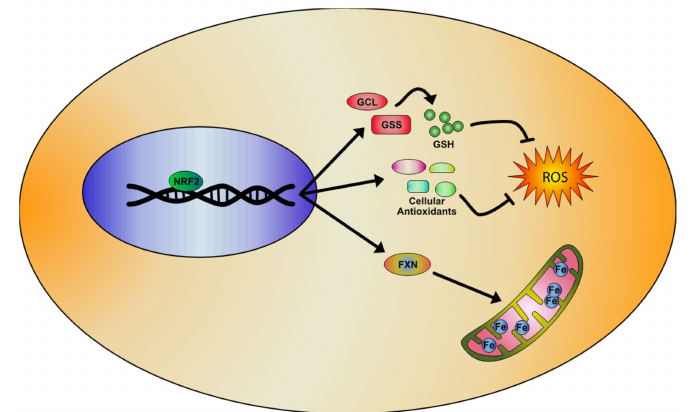
Figure 2. Representative model of the NRF2 signaling pathway activation in Friedreich’s Ataxia (FA), based on literature evidences. NRF2 inducers determine the activation of antioxidant genes transcription and the upregulation of enzymes involved in the regulation of glutathione (GSH) expression, rebalancing the unpaired GSH / GSSG ratio and reducing oxidative stress and lipid peroxidation. Importantly, NRF2 also increases frataxin (FXN) levels, thus partially rescuing the mitochondrial defects observed in FA